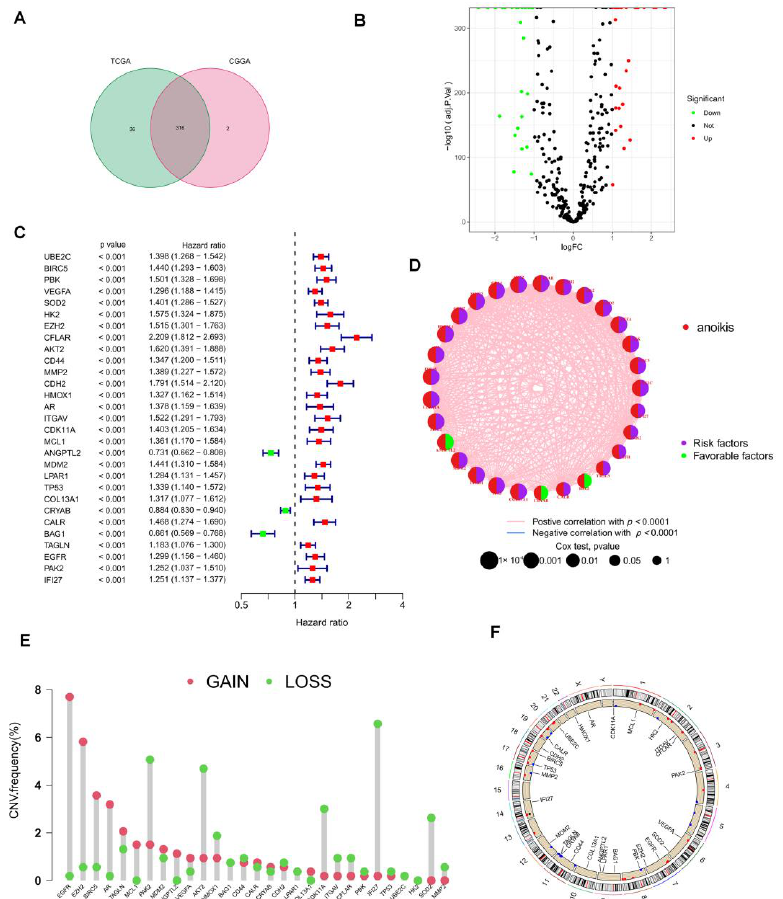
Figure 2. Characteristics of ANRGs in LGG. ( A ) Venn diagram showing the 316 ANRGs found from the TCGA and CGGA cohorts. ( B ) Volcano plot of 57 DEGs in TCGA and GTEx cohort, red for up-regulated, blue for down-regulated genes. ( C ) The forest plot shows the 29 ANRGs ( p < 0.001) via the univariate Cox regression analysis. ( D ) The network diagram showed the correlations between the top 29ANRGs. The red connecting lines represent positive correlations, while the blue represents negative correlations. ( E ) Copy number variations (CNVs) of 29 ANRGs in TCGA-LGG. ( F ) Localization of 29 ANRGs in chromosomal regions.